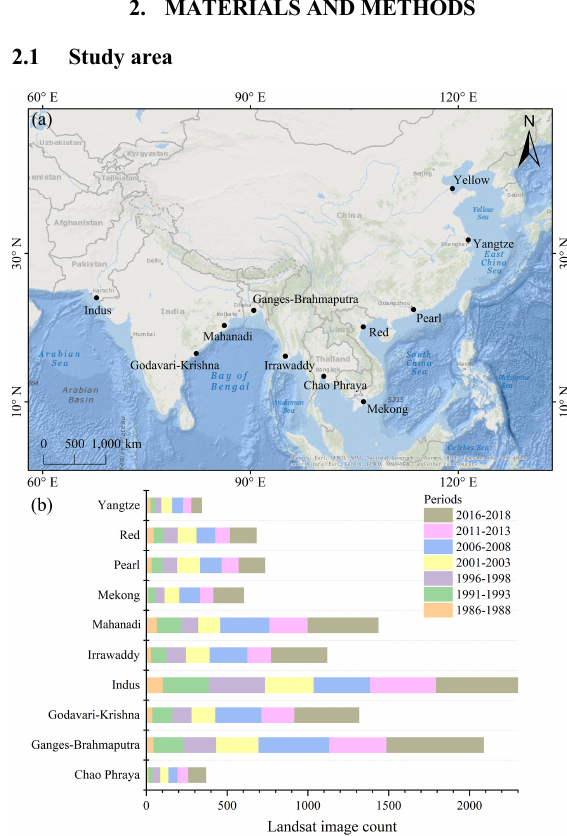
Figure 1. (a) Map of Asia's major river deltas in this study, and (b) statistics of Landsat surface reflectance image applied to each delta. Figure 2. Flowchart of the methodology adopted in this